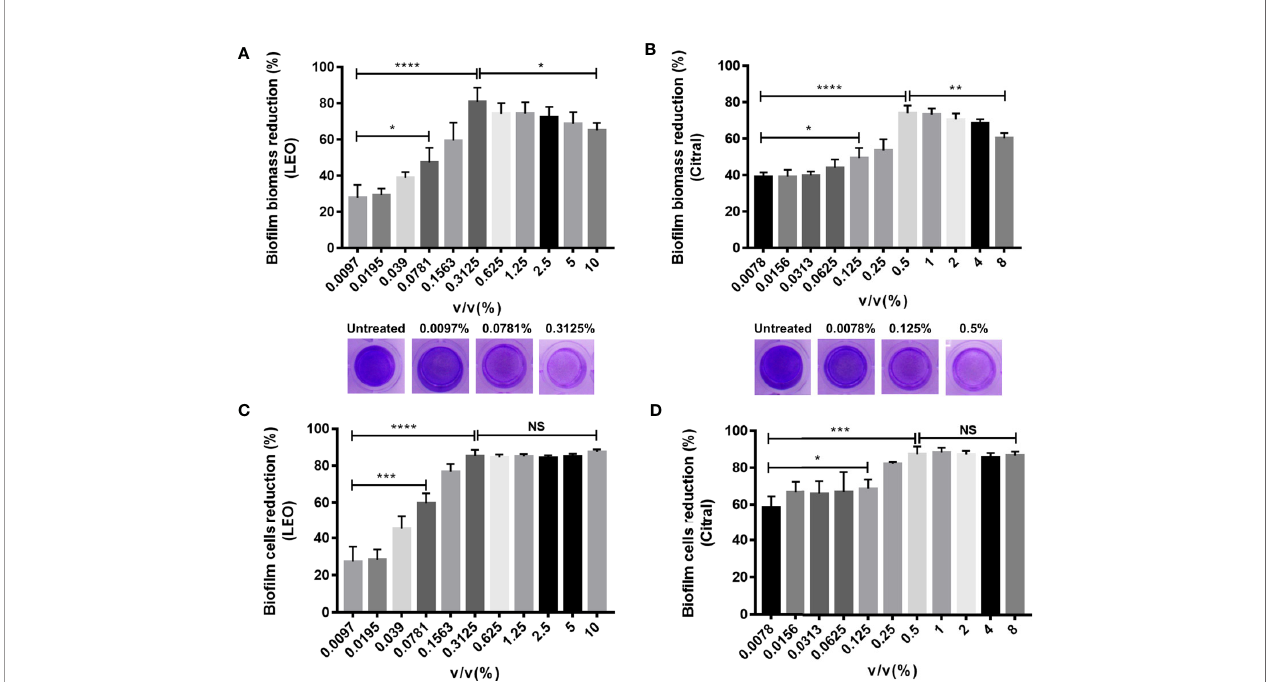
FIGURE 2 | Antibio fi lm activity of lemongrass essential oil or citral on dual-species bio fi lms of C. albicans and S. aureus after 24 h treatment. (A) Effect of lemongrass essential oil on bio fi lm biomass. The upper fi gure shows quanti fi cation data and the lower fi gures show representative bio fi lms stained by CV. (B) Effect of citral on bio fi lm biomass. The upper fi gure shows quanti fi cation data and the lower fi gures show the bio fi lms stained by crystal violet. (C) Effect of lemongrass essential oil on cell viability in bio fi lm. (D) Effect of citral on cell viability in bio fi lm. Data are shown as mean ± SD (n=3). *p < 0.05, **p < 0.01, ***p < 0.001,